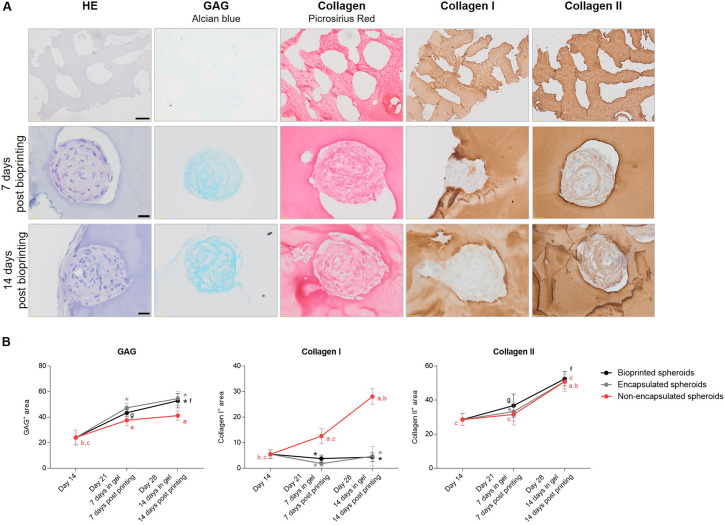
Evaluation of cartilaginous phenotype of microtissues post printing. (A) HE staining was performed to assess overall morphology, Alcian Blue staining showed the presence of glycosaminoglycans (GAG). Collagen was visualized by Picrosirius Red (PSR) staining and IHC stainings for collagen type I and type II were performed. Scale bar 20 μm. (B) Graphs represent the quantification of GAG, collagen I and collagen II positive stained areas within bioprinted spheroids as compared to encapsulated spheroids in gelMA/Li-TPO-L and non-encapsulated spheroids from corresponding culture timepoints. All data are presented as mean ± 95% CI. For non-encapsulated spheroids, significant differences (p < 0.05) between culture timepoints were marked a compared to day 14, b to day 21, and c to day 28 spheroids. For encapsulated spheroids significant differences (p < 0.05) between culture timepoints were marked d compared to 7 days post encapsulation and e to 14 days post encapsulation. For bioprinted spheroids significant differences (p < 0.05) between culture timepoints were marked f compared to 7 days post printing and g to 14 days post printing. For both encapsulated (in gray) and bioprinted spheroids (in black) significant differences compared to the non-encapsulated spheroid controls were marked * (n = 6, One-way ANOVA followed by a Tukey’s post hoc test).